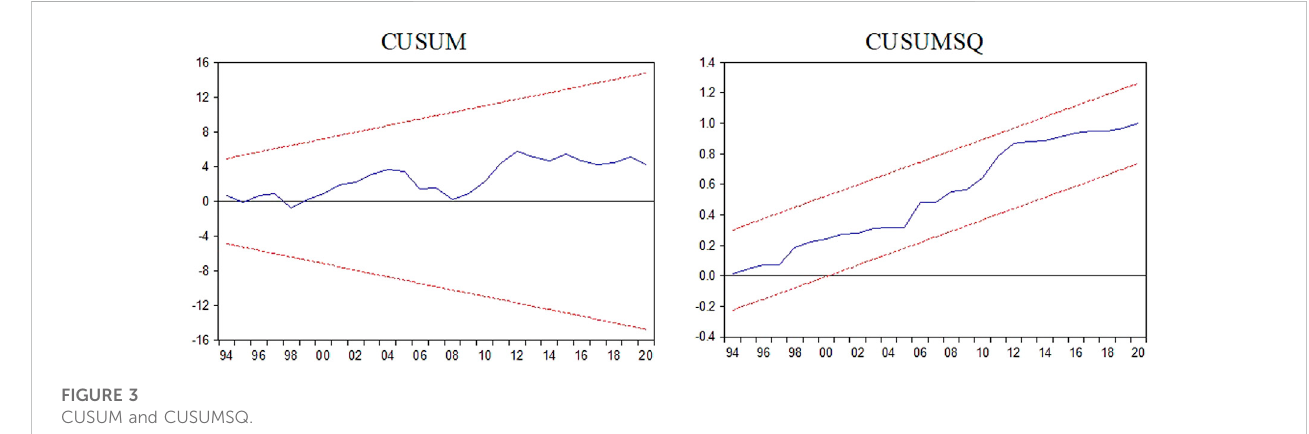
FIGURE 3 CUSUM and CUSUMSQ.